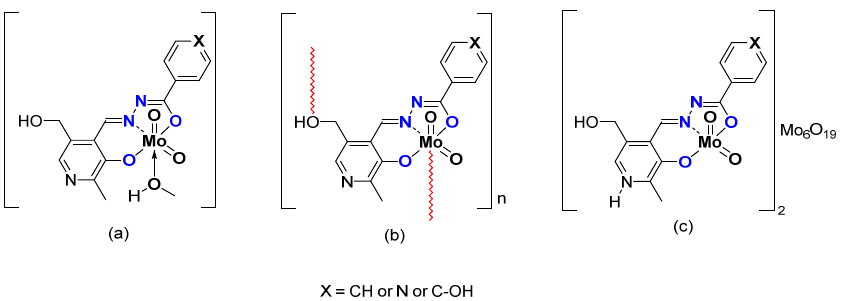
Table 4. Results of CO epoxidation and selectivity toward COE under organic solvent free condi- tions with MoO 2 L complexes from Figure 7.